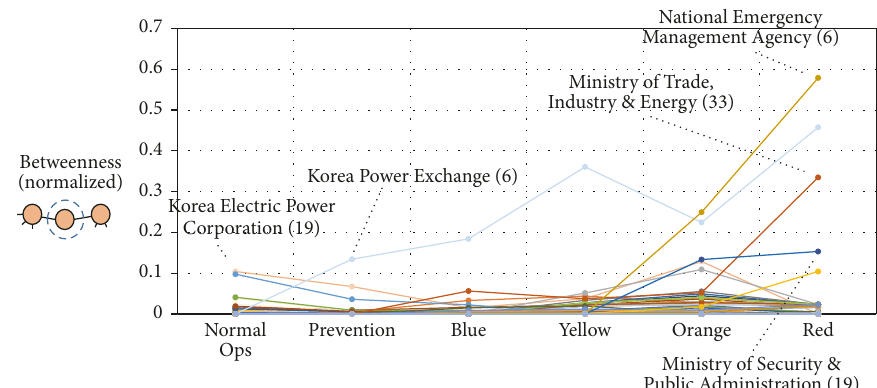
Figure 5: Betweenness and number of roles for Korean blackout management organizations. Each line represents a different organization. As the majority of organizations are periphery actors, they have low betweenness compared to few central, coordinating organizations. These central and important organizations arelabelled: name (number of crisis management roles). Results demonstratethat few organizations from both electric power and emergency management sectors are the key crisis coordinator for different blackout risks, specifically KEPCO, KPX, and NEMA. In contrast, MOTIE and MOSPA are key decision-making organizations, yet they remain periphery to information